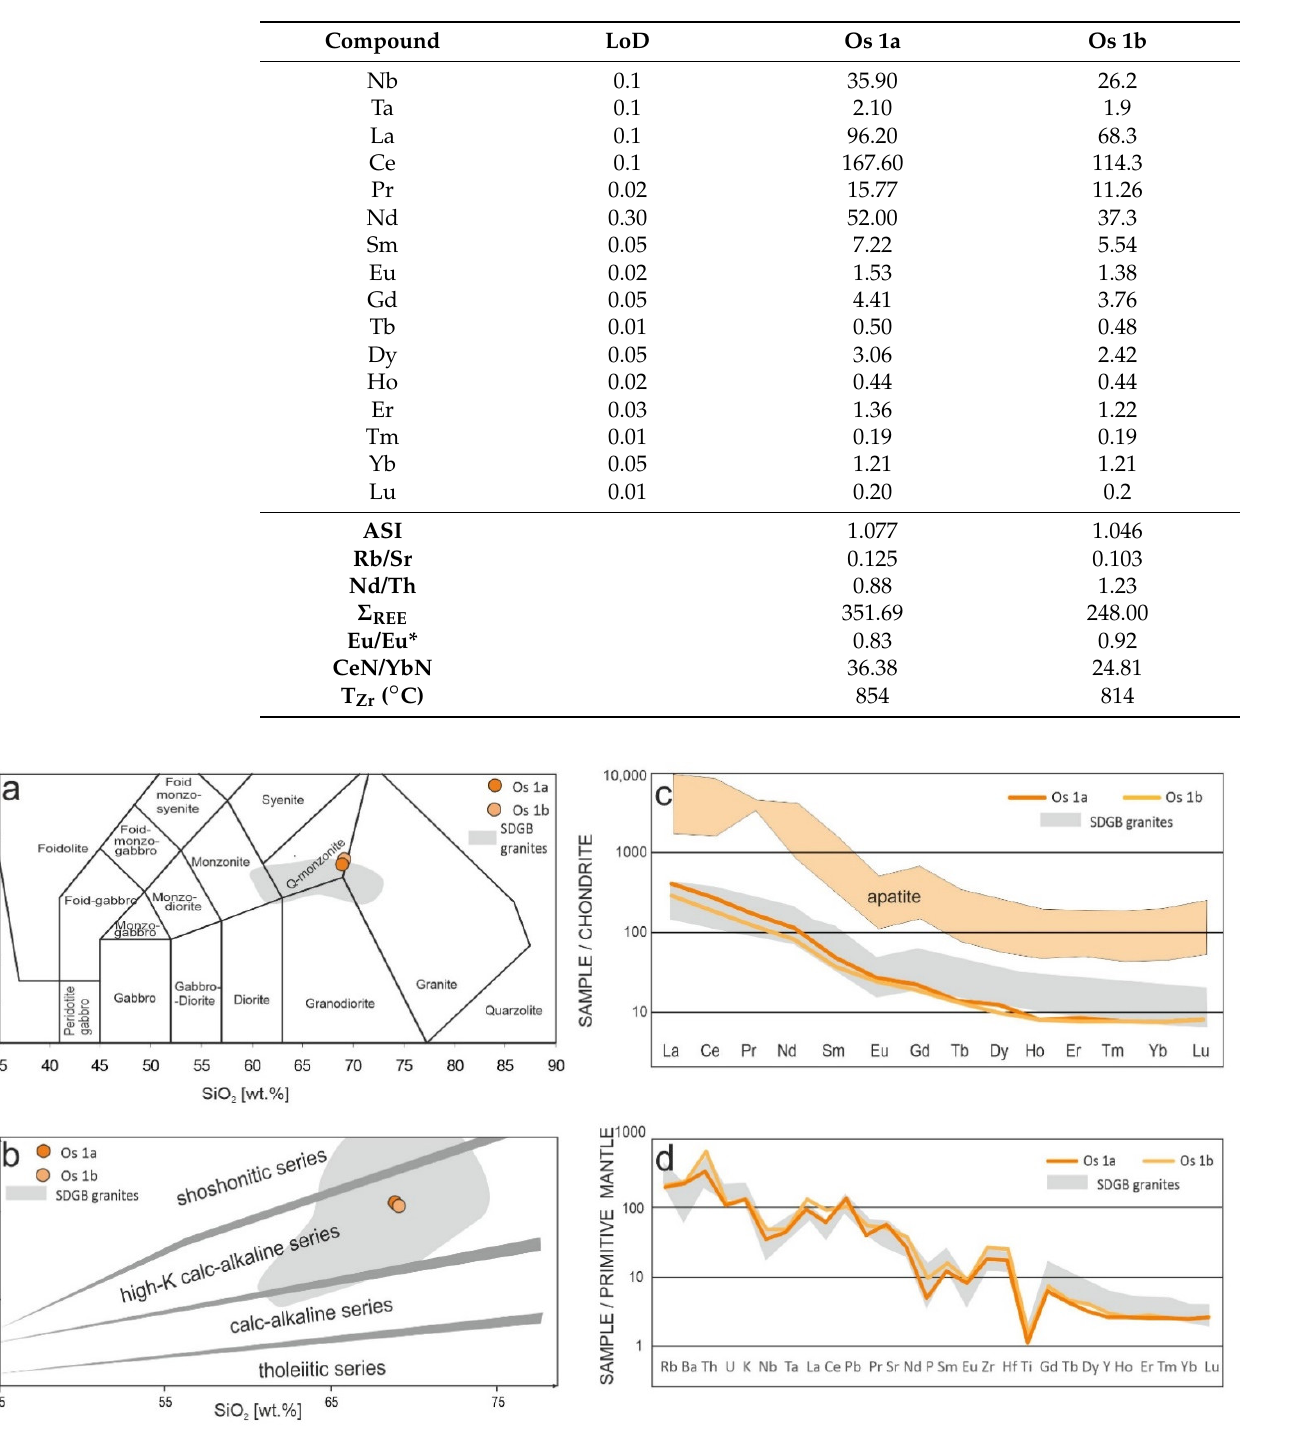
Figure 3. Classification position of the granitoid from Osielec in ( a ) alkali (K 2 O + Na 2 O) versus SiO 2 TAS classification diagram after [33]; ( b ) K 2 O versus SiO 2 classification diagram after [34]; ( c ) chondrite (C1)-normalized REE patterns of the granitoid from Osielec and apatite from the sample (gray area); ( d ) primitive mantle normalized multielement patterns of the analyzed exotic block from Osielec stream. Normalization values after [18], gray field—analyses from [35].